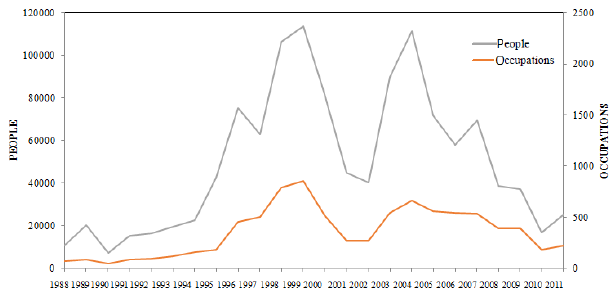
Figure 3. Number of land occupations and people involved, 1988–2011. Source: Based on